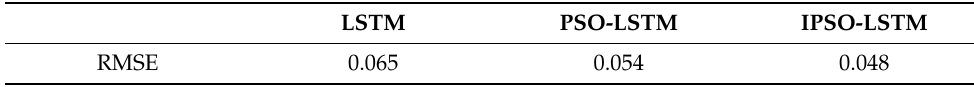
Table 5. The RMSE of LSTM with different optimization